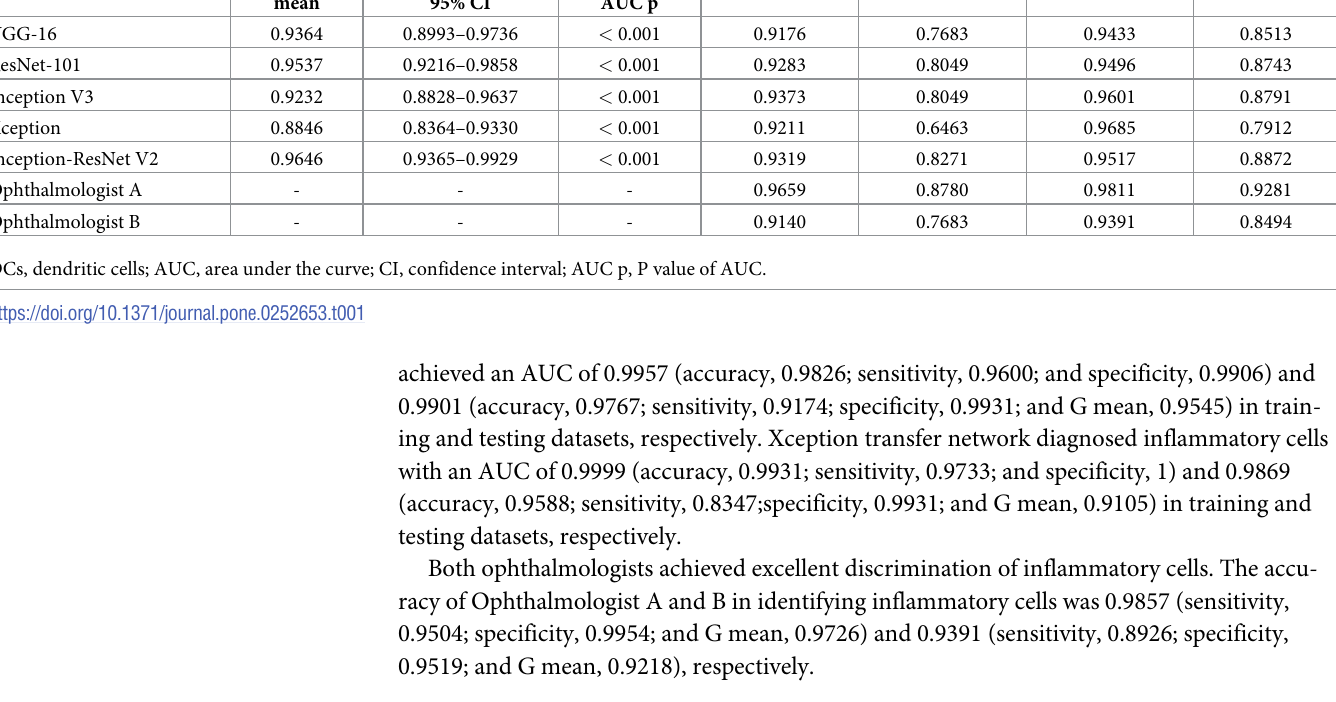
Table 1. External validation results of five transfer networks and two ophthalmologists in detecting activated dendritic cells (DCs). Transfer network